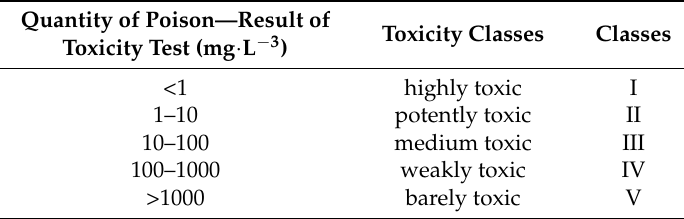
Table 1. Toxicity classes of poisonous substances [54].